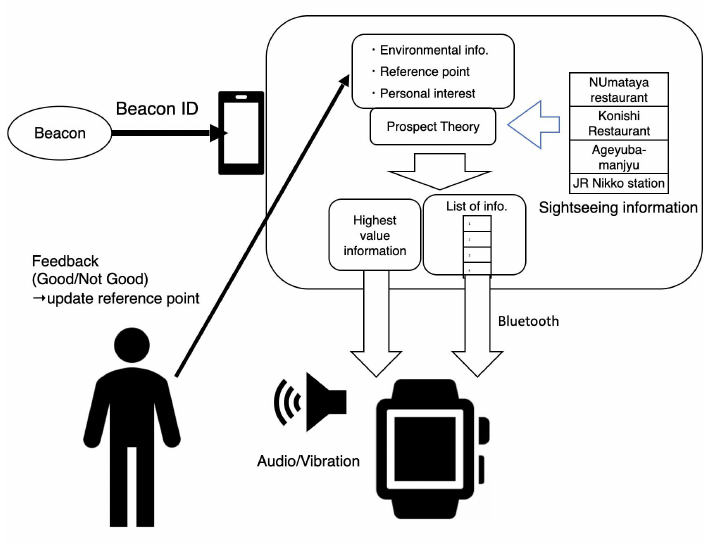
Figure 14. Outline of the behavior of the